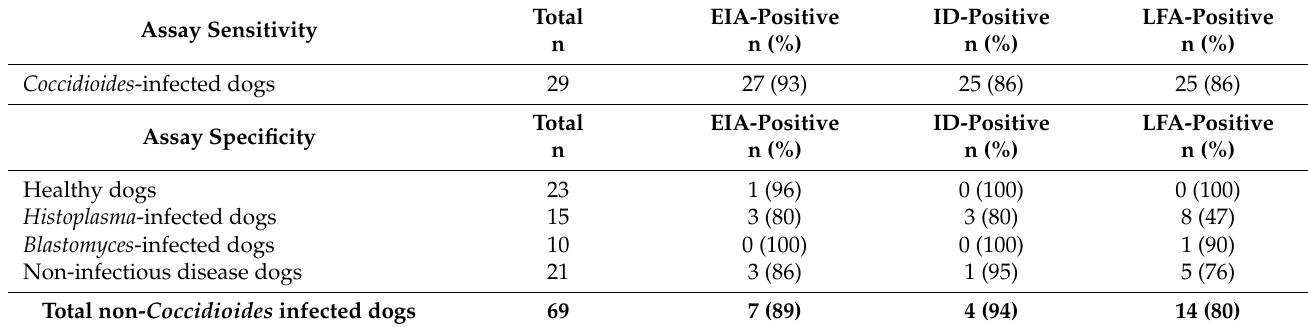
Table 1. Comparison of sensitivity and specificity of Coccidioides antibody detection